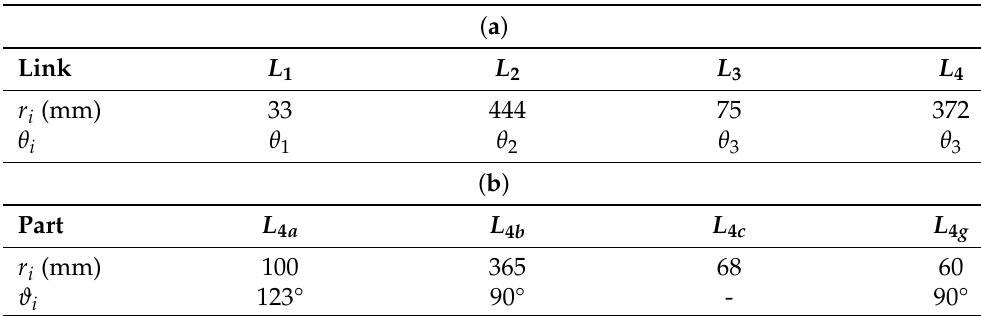
Table 2. Parameters of the robotic arm † : ( a ) the simplified four-bar mechanism as in Figure 12c, and ( b ) the detail of the components of the link L 4